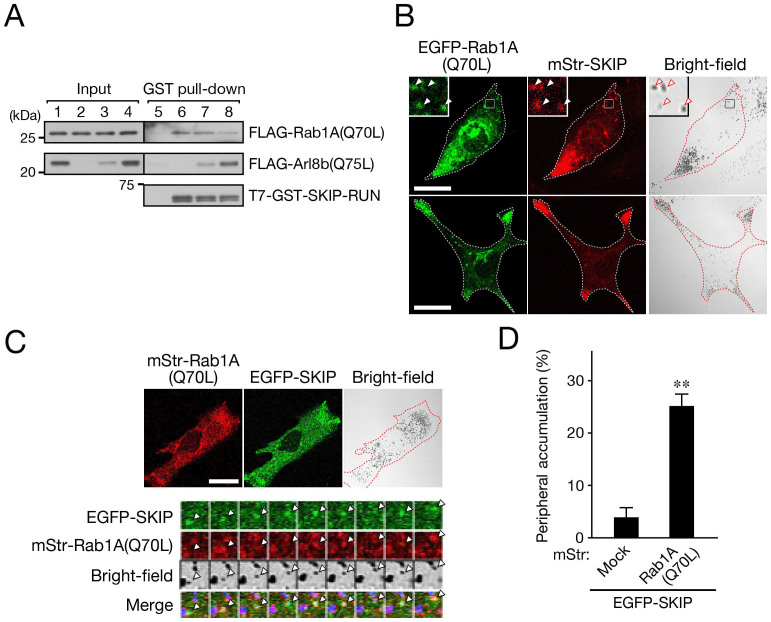
Rab1A on melanosomes interacts with SKIP and regulates anterograde melanosome transport.(A) Competition experiments revealed that Arl8b-binding and Rab1A-binding to SKIP are mutually exclusive. Glutathione Sepharose beads coupled with T7-GST-SKIP-RUN or beads alone were incubated with solutions containing FLAG-Rab1A(Q70L) and/or an increasing amount of FLAG-Arl8b(Q75L), and the proteins bound to the beads were analyzed by immunoblotting with the antibodies indicated. Input shows a 1/140 volume of the reaction mixture used for the GST pull-down assays. The positions of the molecular mass markers are shown on the left. Note that Rab1A binding to SKIP was reduced by an increasing amount of Arl8b (the signal intensity values of bound FLAG-Rab1A(Q70L) normalized to T7-GST-SKIP-RUN signals are 1.0 (lane 6), 0.95 (lane 7), and 0.36 (lane 8)). (B) Typical images of melan-a cells expressing EGFP-Rab1A(Q70L) together with mStr-SKIP are shown. The insets are magnified views of the boxed areas showing that Rab1A colocalized with SKIP at melanosomes (arrowheads). Note that cells expressing EGFP-Rab1A(Q70L) together with mStr-SKIP exhibited peripheral melanosome accumulation. (C) Live cell images of melan-a cells expressing EGFP-SKIP and mStr-Rab1A(Q70L), and montage images showing colocalization of both EGFP-SKIP and mStr-Rab1A(Q70L) at a melanosome and moving with it toward the cell periphery (arrowheads). Images of the cells in (B) and (C) exhibiting peripheral melanosome accumulation are outlined with a broken line. Scale bars, 20 μm. (D) Quantification of the results shown in (C). The results are expressed as the percentages of transfected cells that exhibited peripheral melanosome accumulation, and the bars represent the means and S.E. of the data from three independent experiments (n >50). **, p <0.01 in comparison with the mStr- and EGFP-SKIP-expressing cells (Student's unpaired t test).